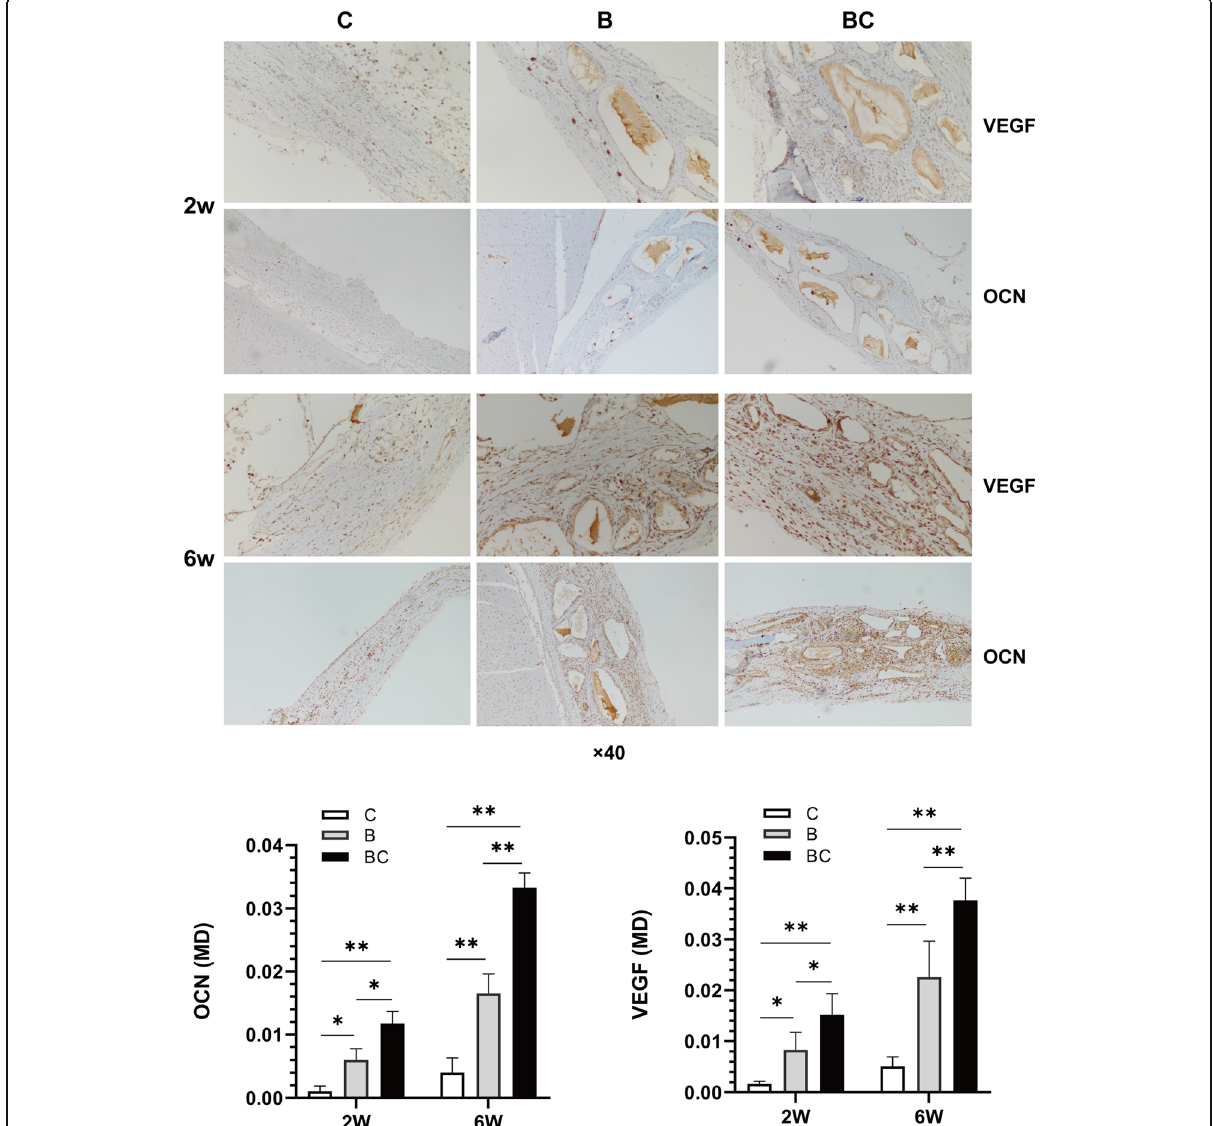
Fig. 6 Immunohistochemical analysis of the expression of VEGF and OCN. At 2 weeks, immunohistochemistry revealed weak intercellular expressions of VEGF and OCN in groups C and B; in group BC, the expressions were more obvious. At 6 weeks, obvious intercellular expressions of VEGF and OCN could be seen in groups C and B; in group BC, the cells were strongly positive for VEGF and OCN. The immunostaining sections were observed under a light microscope at ×200 magnification. Group C, unfilled defect for control; group B, bone collagen alone; group BC, CGF-e + bone collagen. Quantitative analysis showed that the mean density (MD) of VEGF and OCN of BC group was significantly higher than C and B groups. * p < 0.05; ** p <